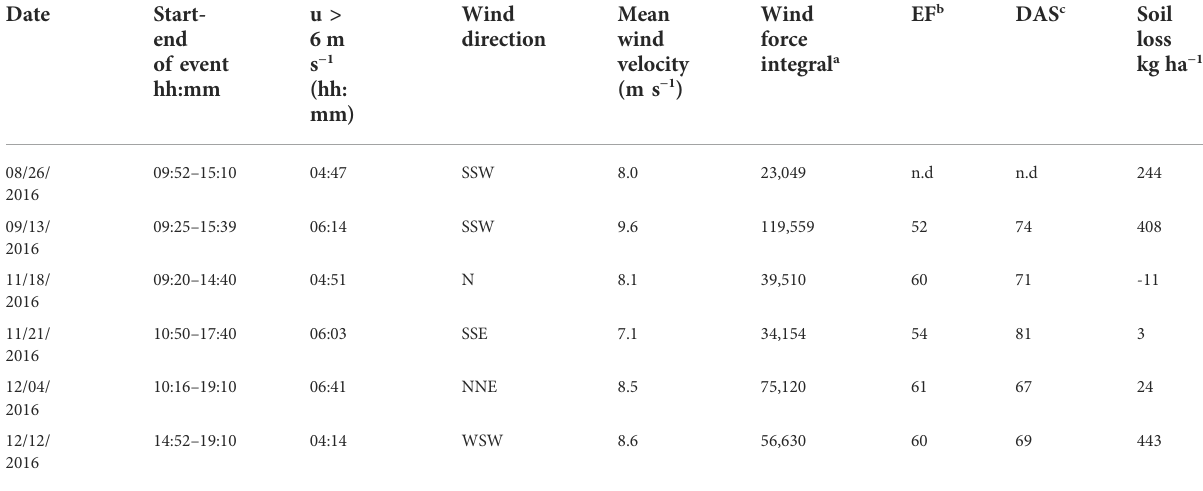
TABLE 1 Description of the erosion events of this study.